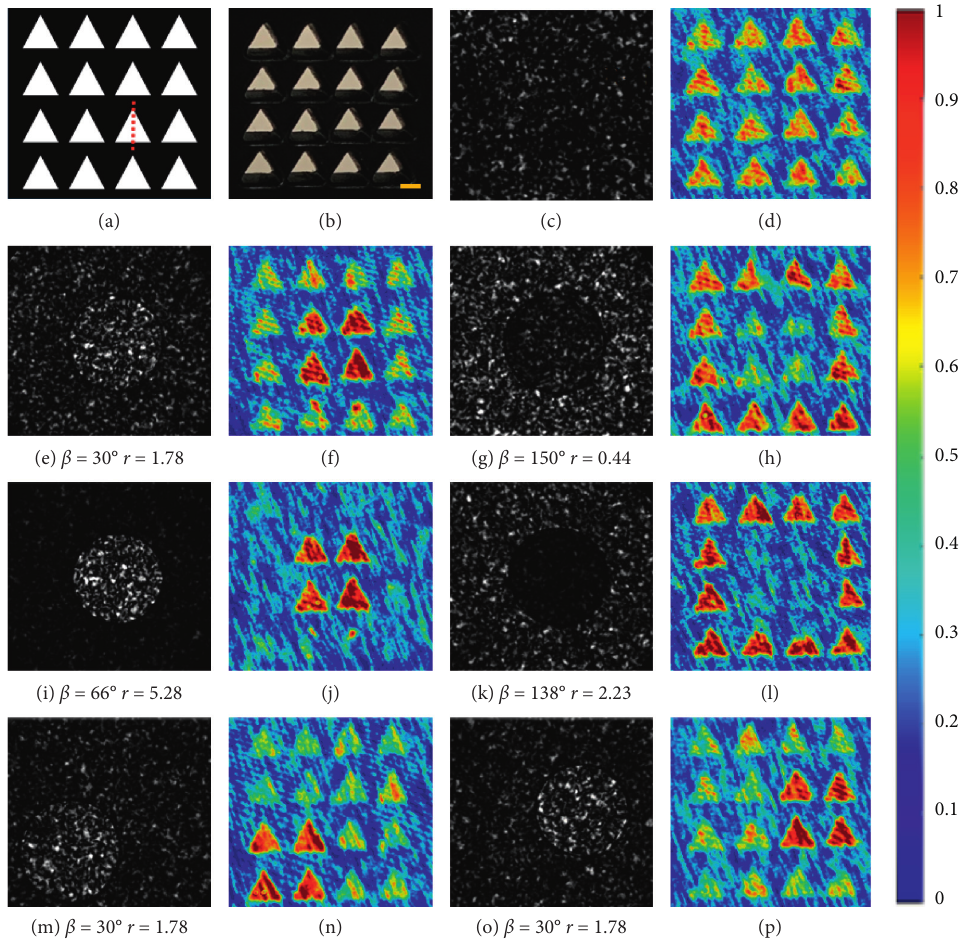
Figure 8: Experimental result of the periodic projection target. (a) The periodic projection target; (b) image of the object captured by the CCD; (c) the original speckle pattern captured by the CCD; (d) the imaging results of (c); (e), (g), (i), and (k) speckle patterns modulated at different polarization angles in the same ROI; (f), (h), (j), and (l) the corresponding imaging results (10,000 measurements); (m) and (o) speckle patterns at the same polarization angles in different ROIs; (n) and (p) the corresponding imaging results (10,000 measurements). The results of this experiment were all subjected to pseudocolor processing. Scale bar �